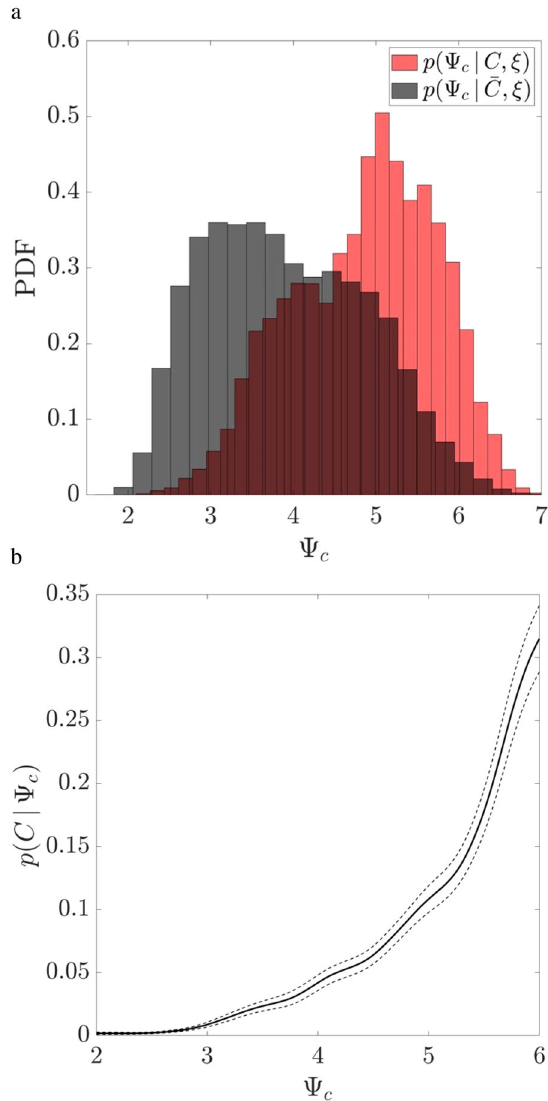
Fig. 6 Performance and robustness of the scalar crack nucleation indicator. a The likelihood distributions of the scalar crack nucleation indicator for cracked and uncracked states, b aggregated posterior distribution of the 66 models, conditioned on only the scalar crack nucleation indicator, for different combinations of ten microstructure in the training data sets. The average of all models is depicted by the dark solid line and the standard deviation bounds are depicted by the dotted